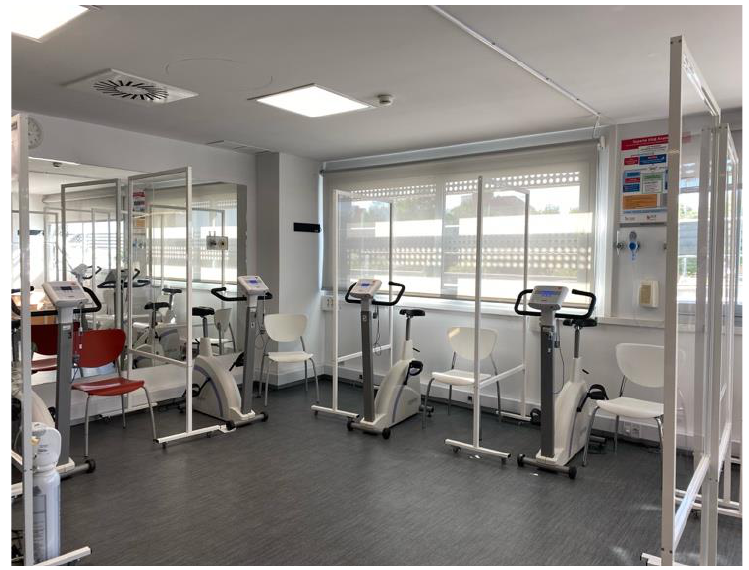
Figure 1. Rehabilitation ward of Rey Juan Carlos Hospital in compliance with COVID normative.